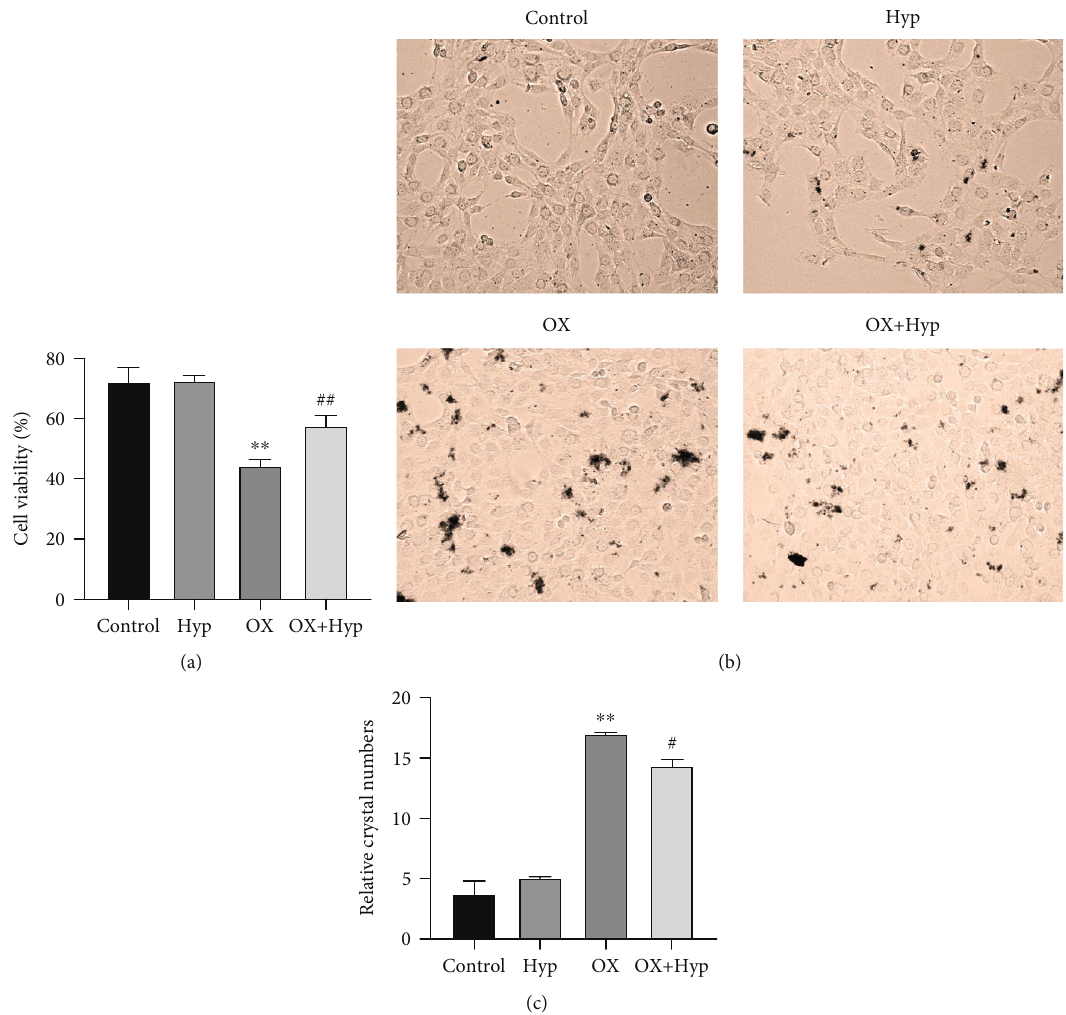
Figure 4: E ff ect of hyperoside on viability and crystal adhesion ability of calcium oxalate-treated HK-2 cells. (a) The viability of HK-2 cells was detected by MTT; (b, c) crystal-cell adhesion assay was applied to detect the adhesion of calcium oxalate crystal to HK-2 cells (200x, (b)) and statistical analysis of the number of crystals adhered to cells (c). ∗∗ P < 0 : 01 vs. control group and # P < 0 : 05 and ## P < 0 : 01 vs. OX